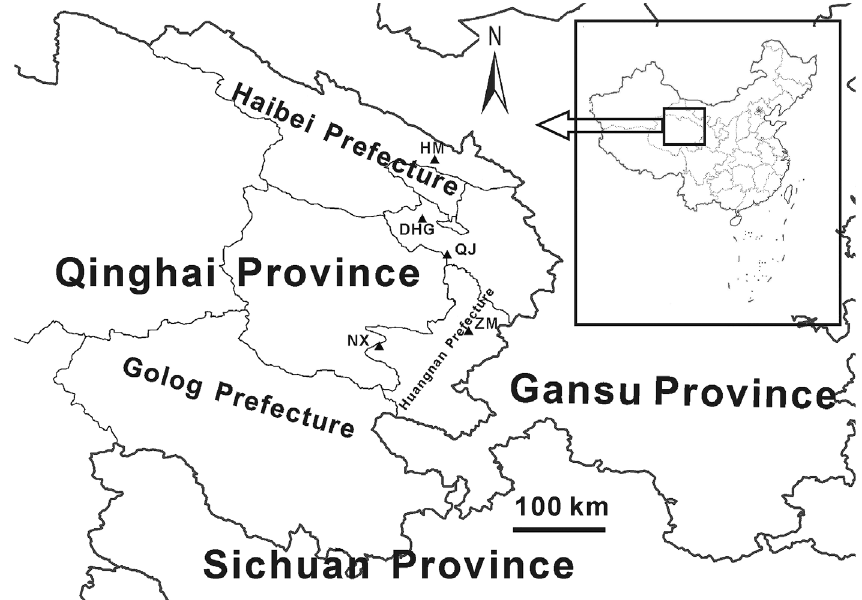
Figure 1 - Locations of the five R. tanguticum populations sampled from Qinghai Province in this